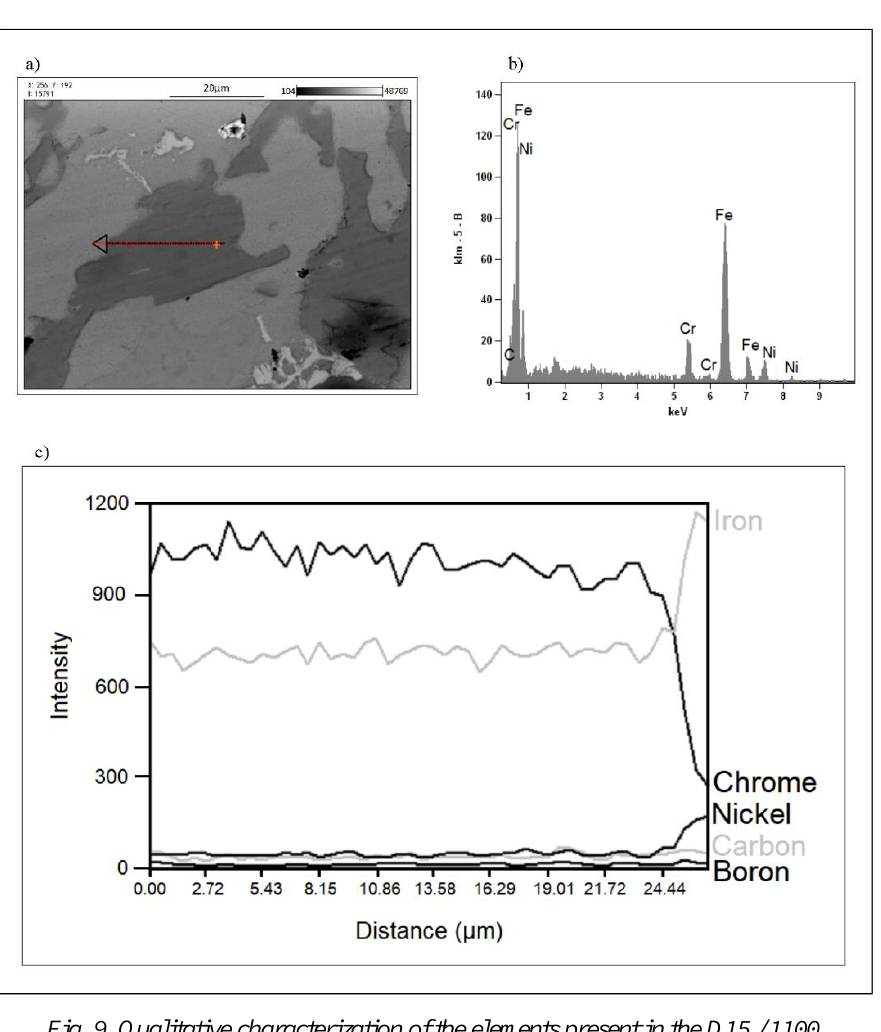
Fig. 9. Qualitative characterization of the elements present in the D15 / 1100 precipitate region by SEM. Image showing the vector used a), General spectrum obtained with in-line EDS-SEM b), graph representing the amount of elements along the vector